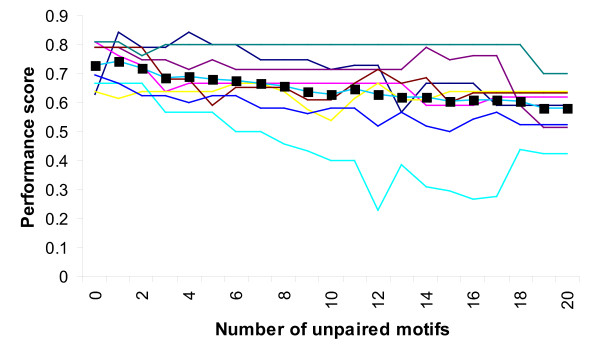
Effect of the alignment step on motif-finding performance. The x-axis shows how many of the orthologous pairs of planted motifs are artificially unpaired in the alignment step. Each solid line represents a separate experiment. The squares plot the average score over eight experiments.